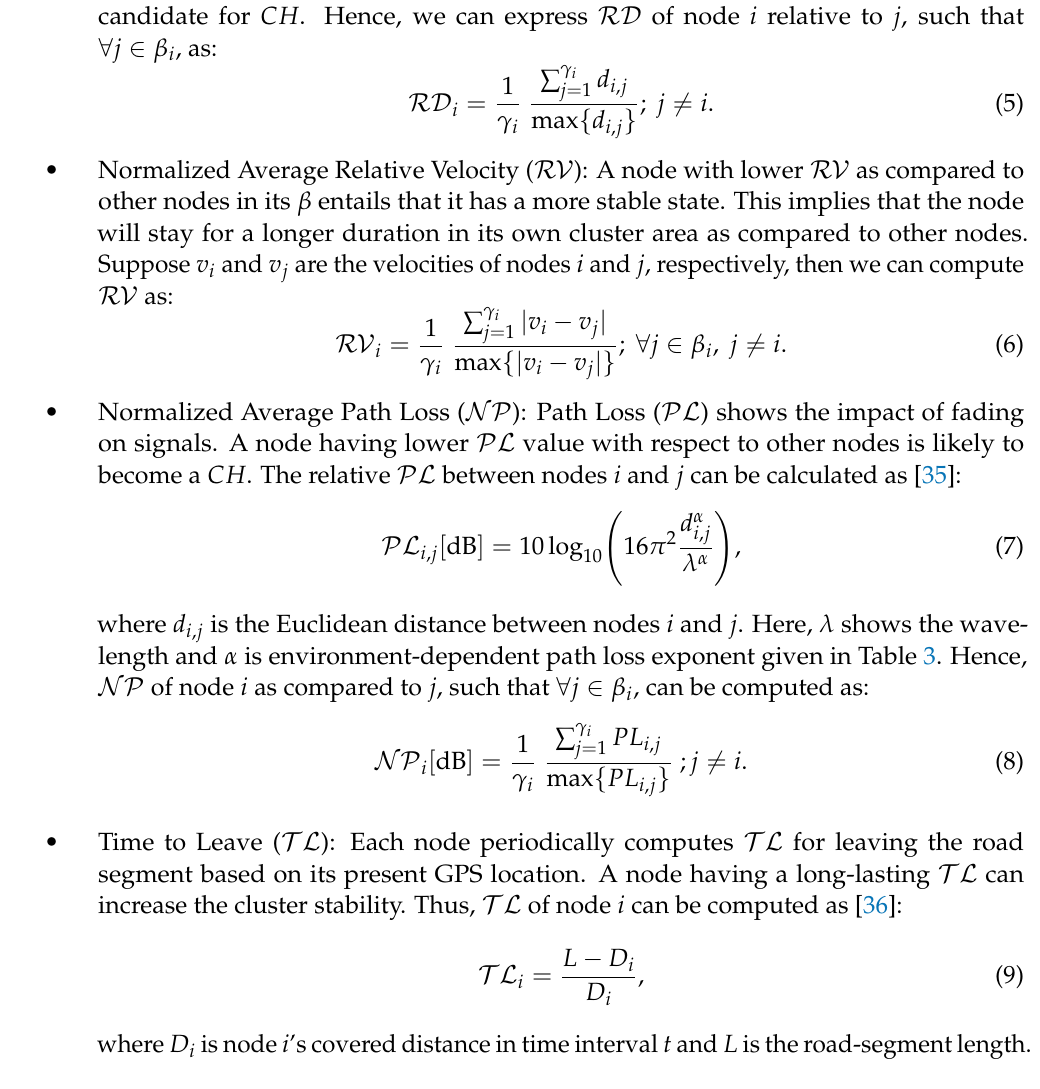
Table 3. Path loss exponent